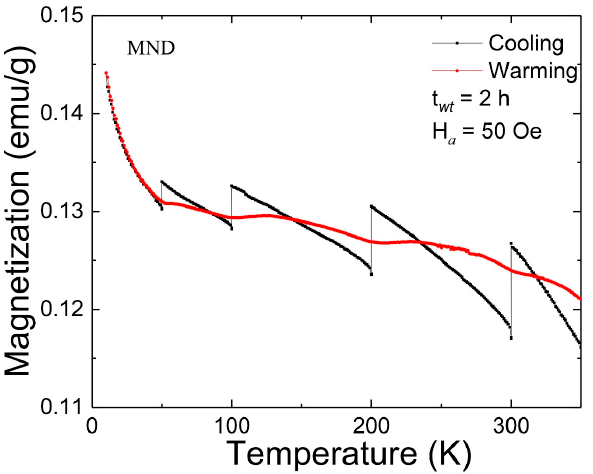
Figure 5. FC magnetic memory effect (MME) from MND measured at 50 Oe.